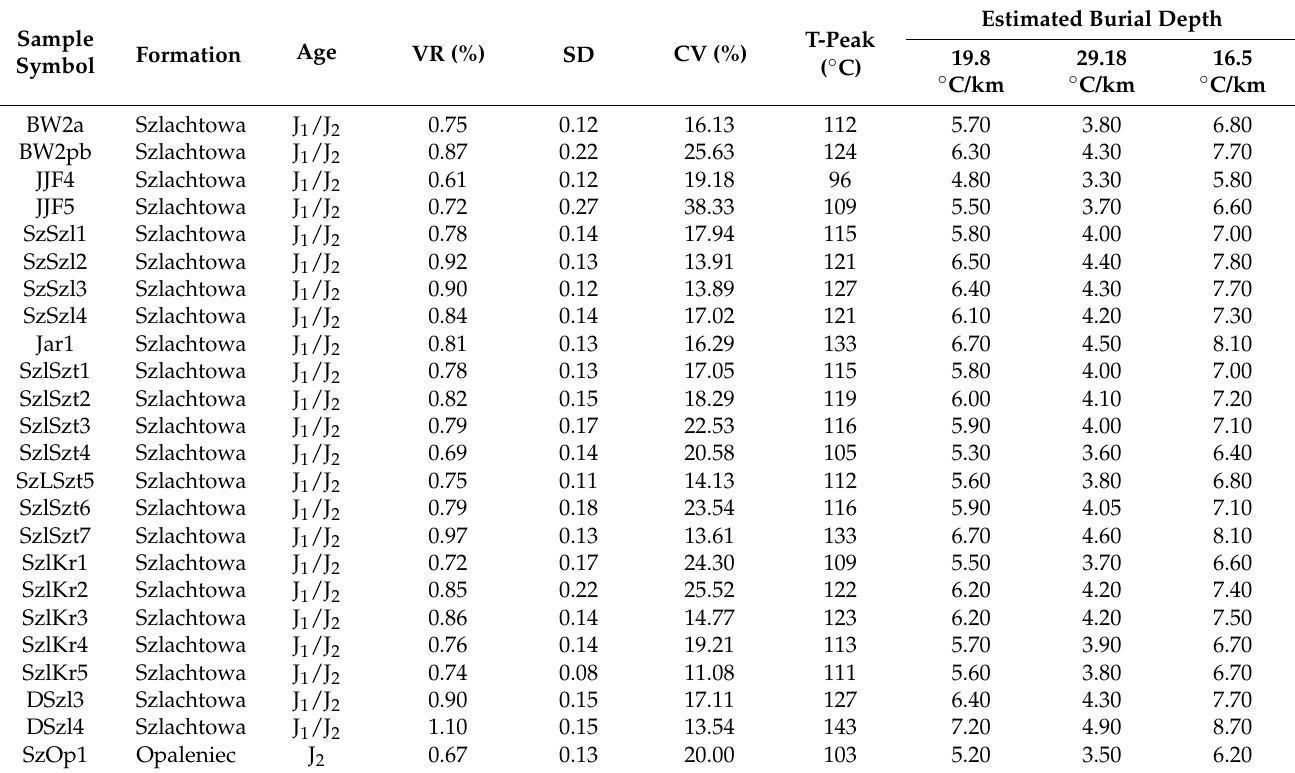
Table A1. Calculation of T-peak and burial depths for particular geothermal gradients